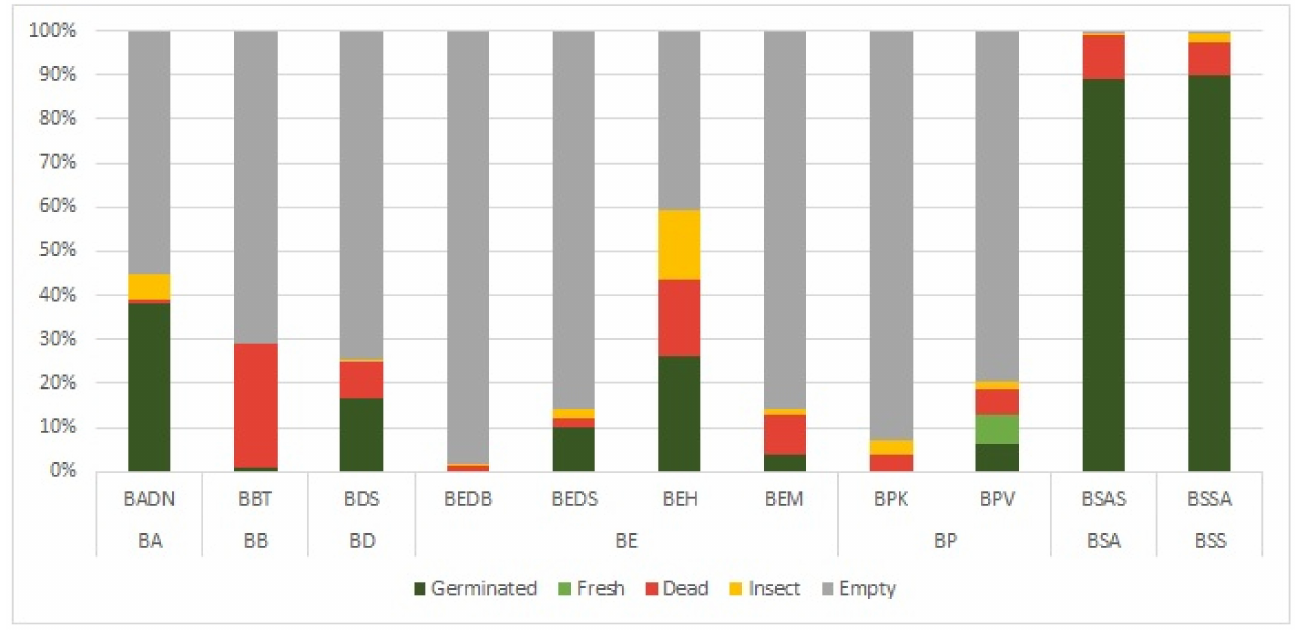
Figure 1. Seed category proportions of the seven Boswellia taxa collected from 12 localities (Socotra Island) in 2020 (for abbreviations, see Table